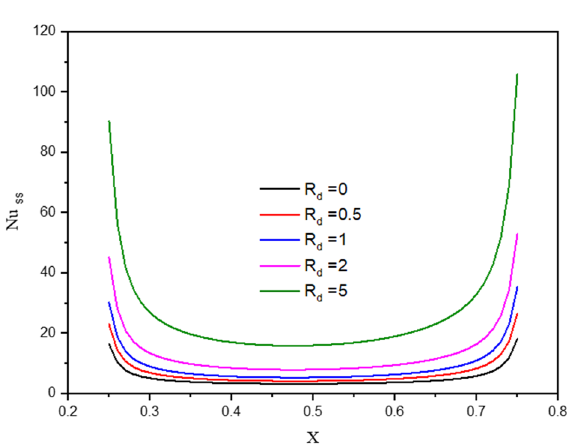
Figure 8. Profiles of Nu ss along with the heat source of a solid phase below the changes on thermal radiation parameter R d for hybrid nanofluid at φ Cu Da = 10 − 3 , Ha = 10, k fs = 1, D = 0.5, k r = 1, H ∗ =